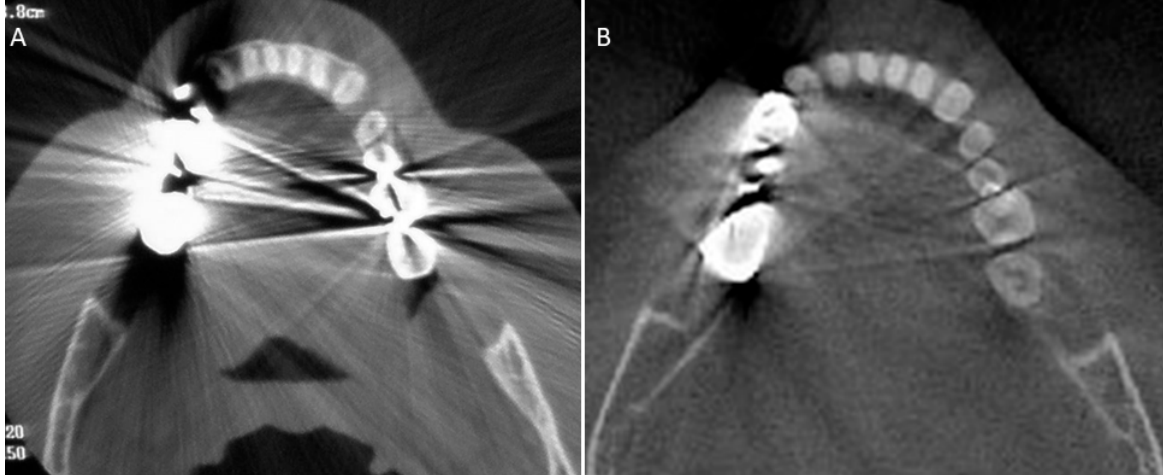
Figure 19. Dental metal artifacts. MSCT vs. CBCT. ( A ) Bone kernel–MSCT axial view of the lower jaw. ( B ) CBCT of the lower jaw carried out at the same level on the same patient. The artifacts from metal material are significantly less evident on CBCT images than MSCT ones.